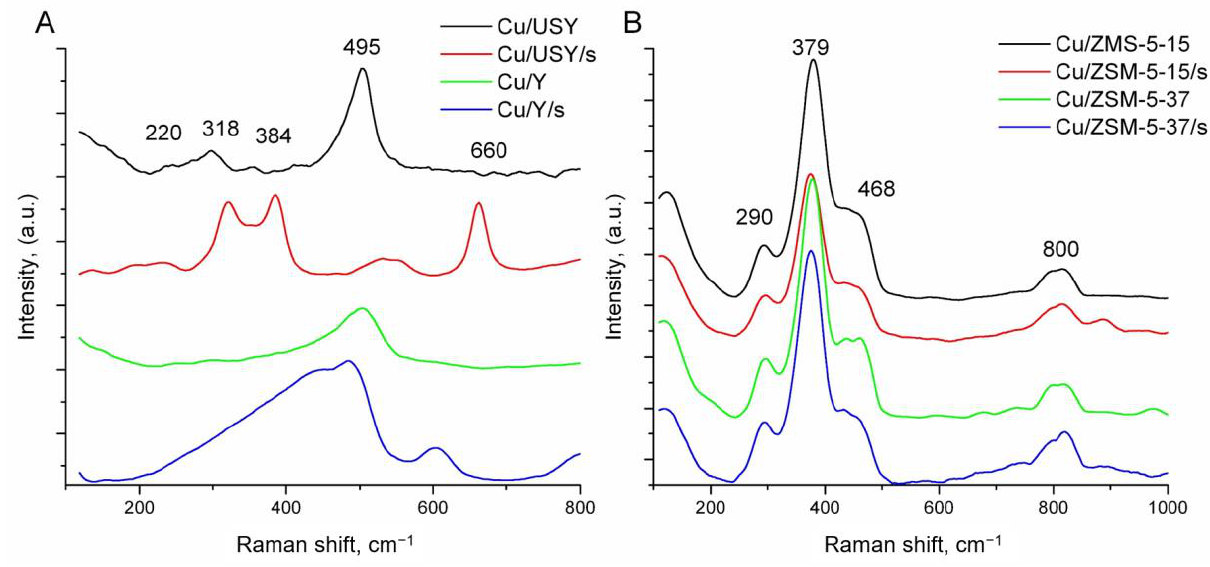
Figure 2. μRaman spectra of the samples; 488 nm line; ( A ) Cu/Y and Cu/USY, ( B ) Cu/ZSM-5-15 and Cu/ZSM-5-37. The results from the static NH 3 sorption experiments are presented in Figure 3A,B.